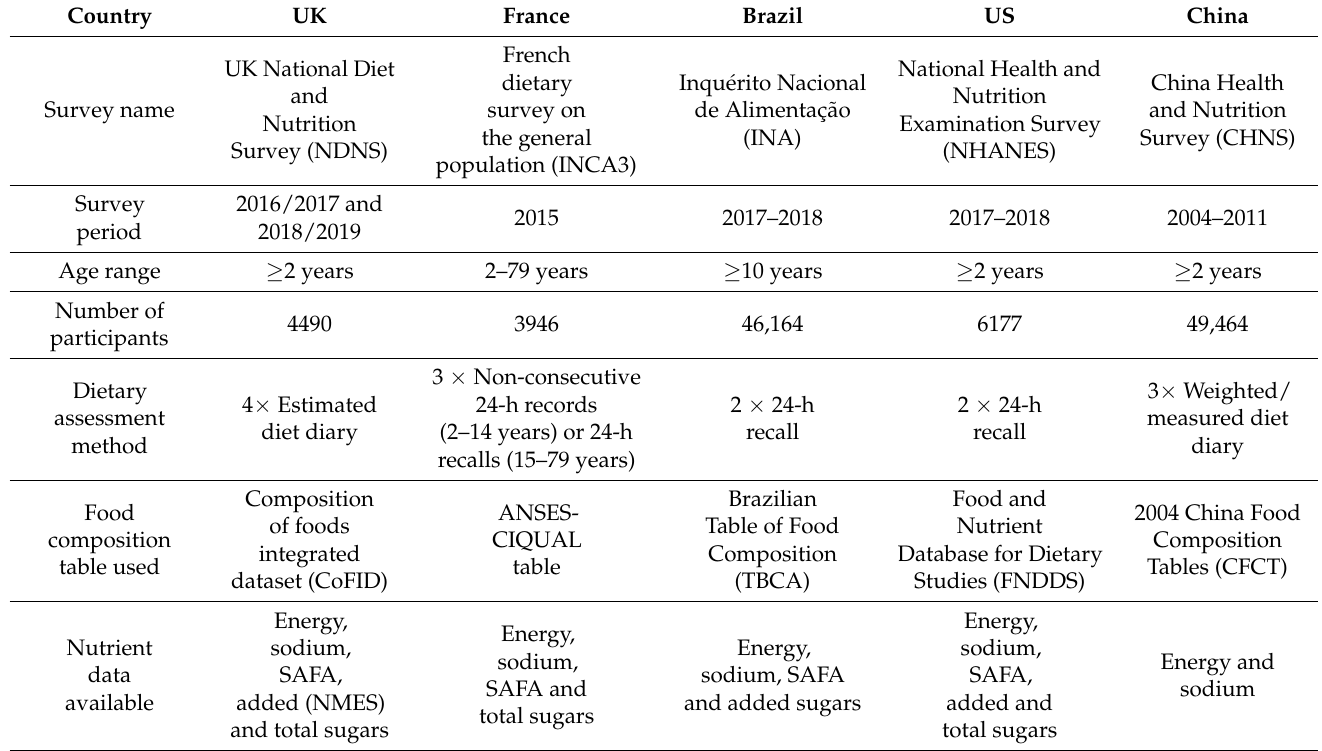
Table 2. Food consumption surveys and food composition tables used in the